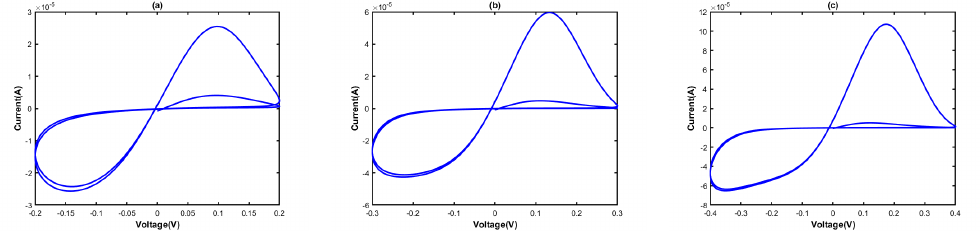
Figure 11. Hysteresis loops for different amplitudes of input voltages, for 16 nm: ( a ) 200 mV, ( b ) 300 mV, and ( c ) 400 mV.